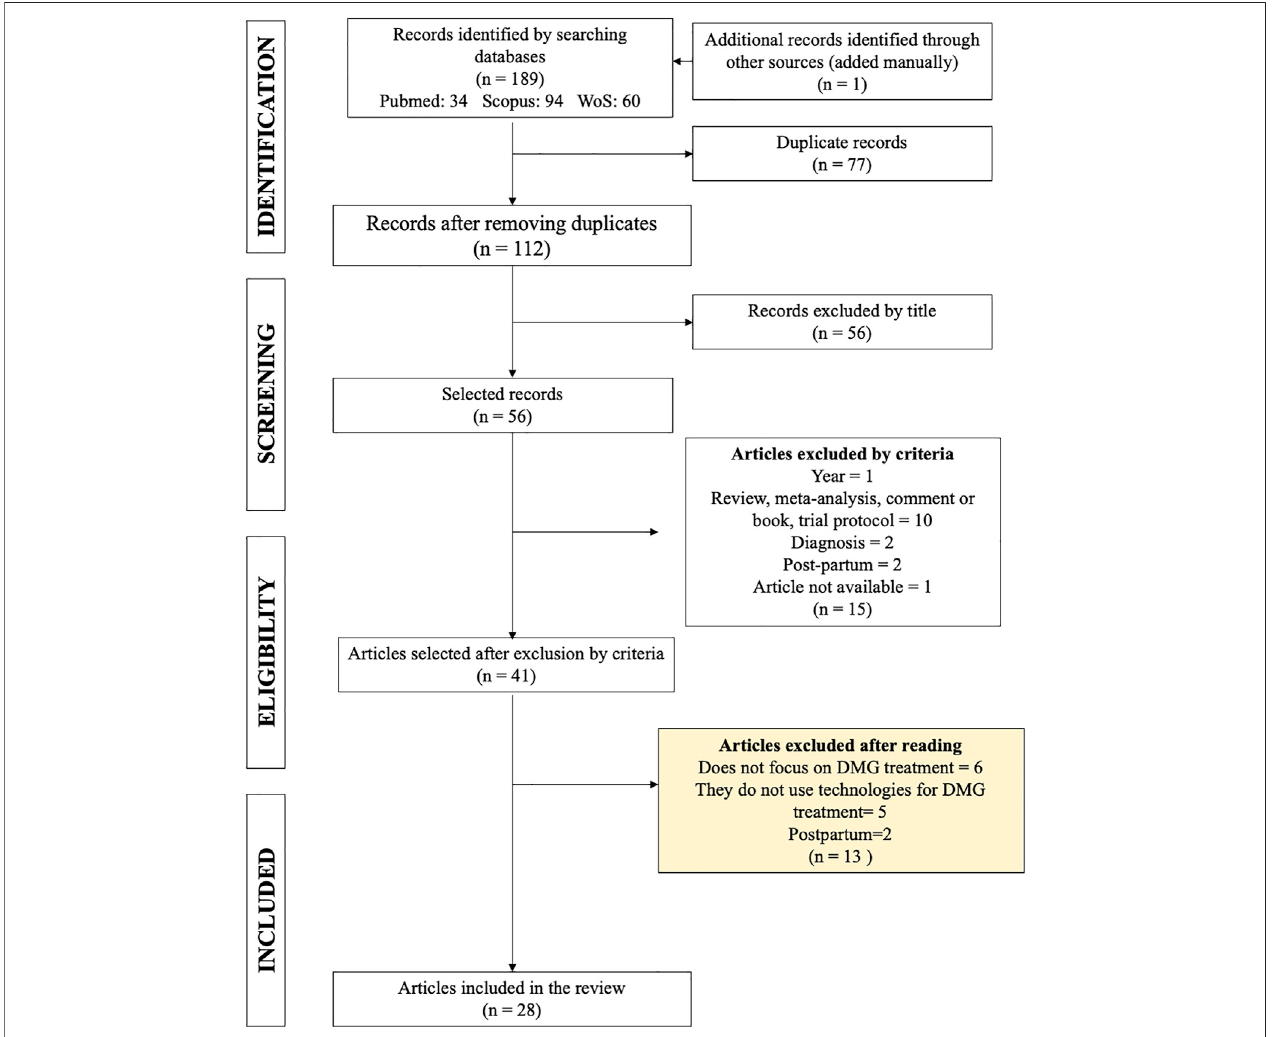
FIGURE 1 | PRISMA diagram for the articles selection